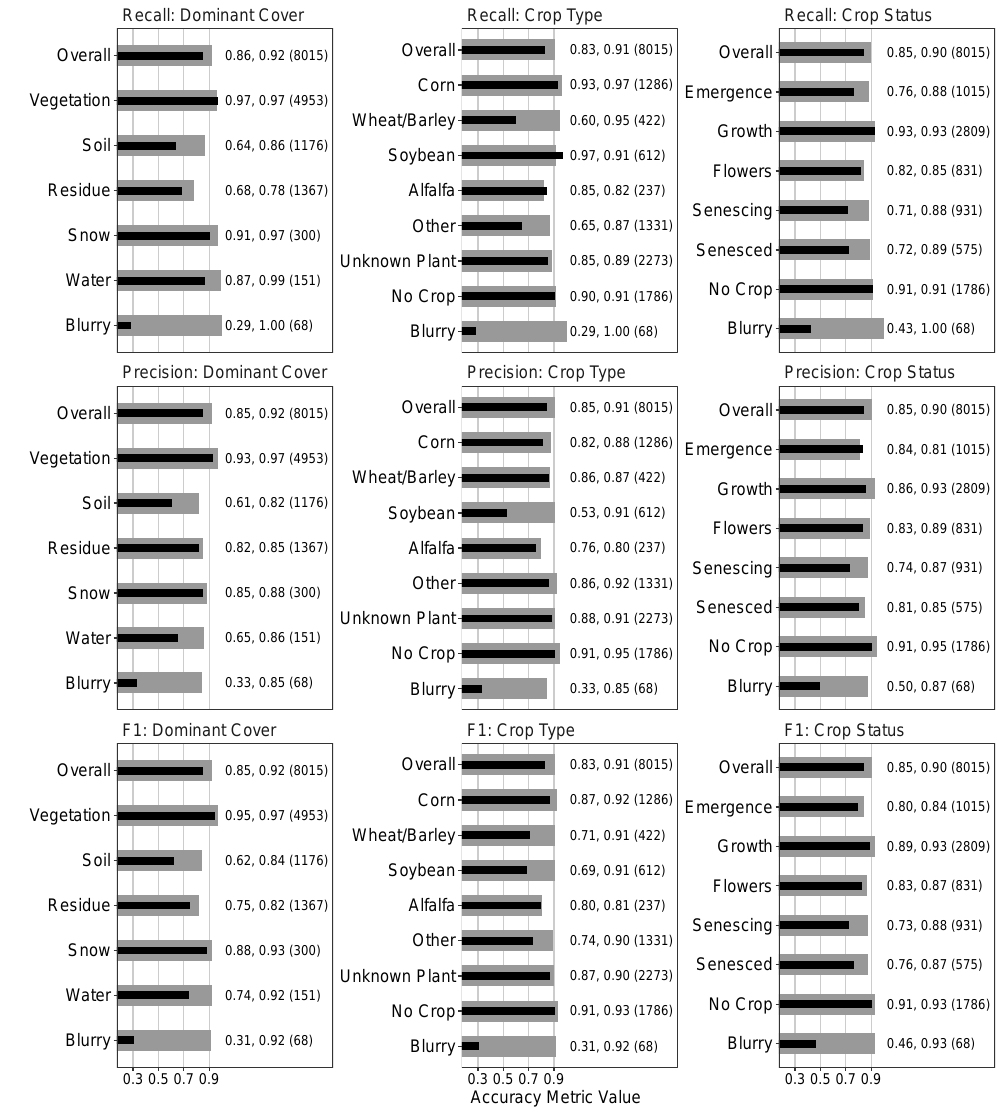
Figure 2. Accuracy metrics for the VGG16 image classifier. The black and grey bars represent the validation and training datasets, respectively. The text indicates the respective metric value for validation, training, and class sample size in parentheses. The training and validation sample sizes are 80% and 20% of the total sample size, respectively. Overall indicates the average metric value for the respective category, weighted by sample size. All three metrics have a range of 0–1, where 1 equals a perfect